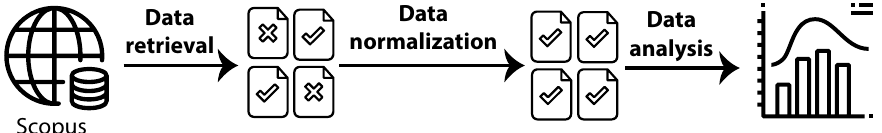
Figure 2. Followed bibliometric